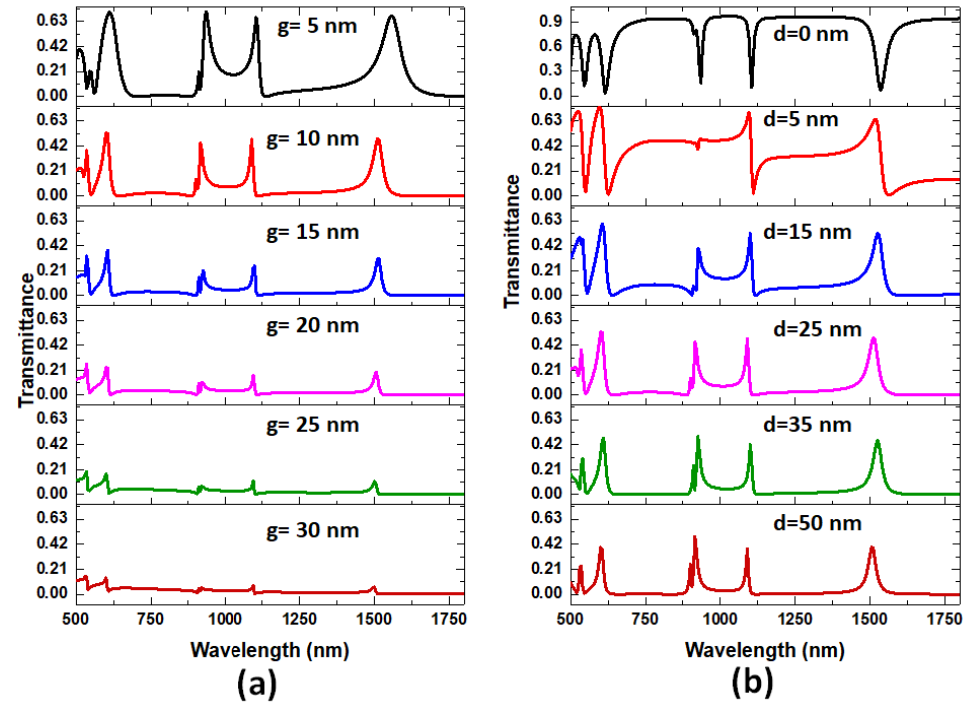
Figure 3. Transmittance spectrum of case 4 by varying ( a ) g = (5, 10, 15, 20, 25, 30) nm, and ( b ) d = (0, 5, 15, 25, 35, 50) nm, respectively.